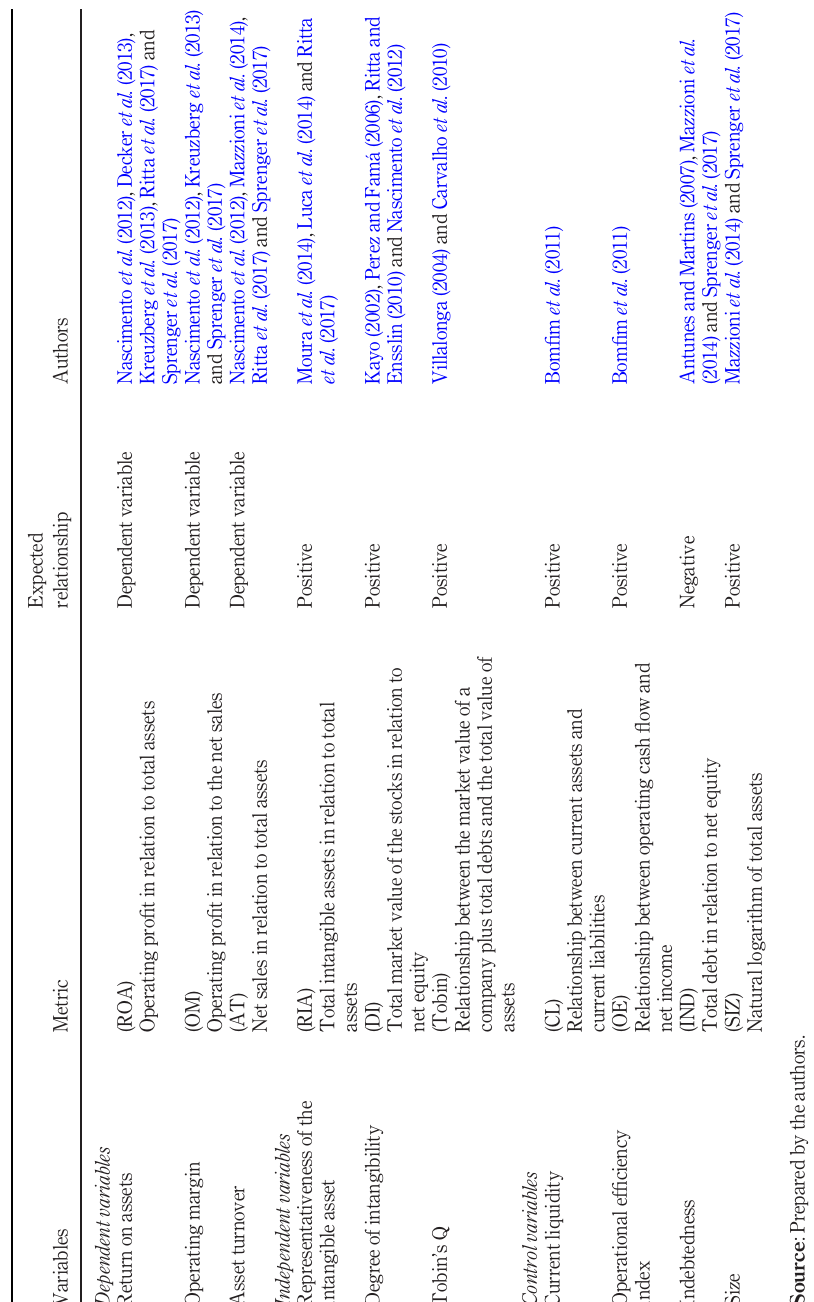
Table 1. Variables of interest in the relationship between intangibility and